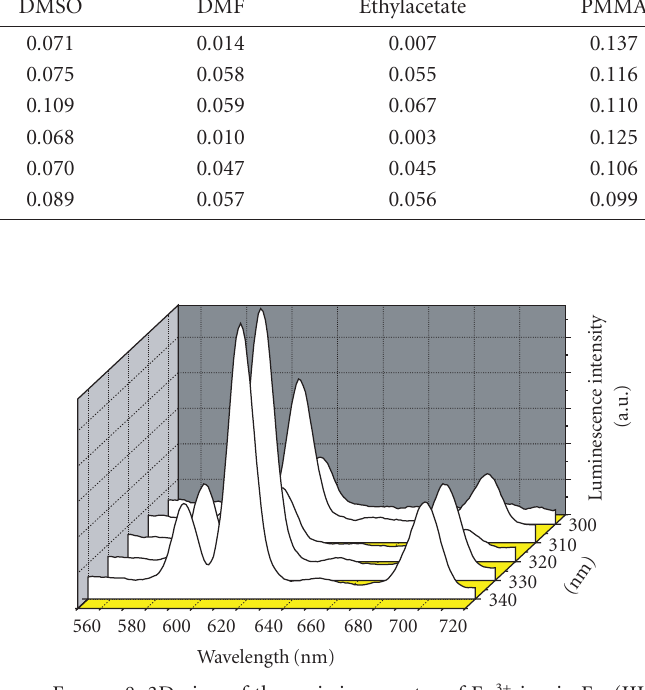
Figure 8: 3D view of the emission spectra of Eu 3+ ion in Eu-(III) complex at di ff erent excitation wavelengths in DMSO.